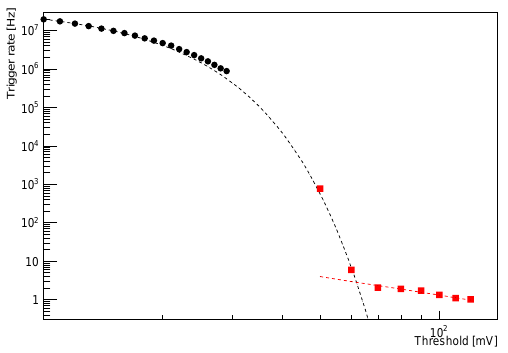
Figure 4: The trigger rate (station 4) as a function of the trigger threshold, measured with the DRS 4 evalu- ation board in Spring 2013 (Epimakhov et al. 2013). Red squares: dead-time corrected data, red dashed line: cosmic ray triggers, black points: estimation of NSB triggers from baseline fluctuations, black dashed curve: the NSB noise